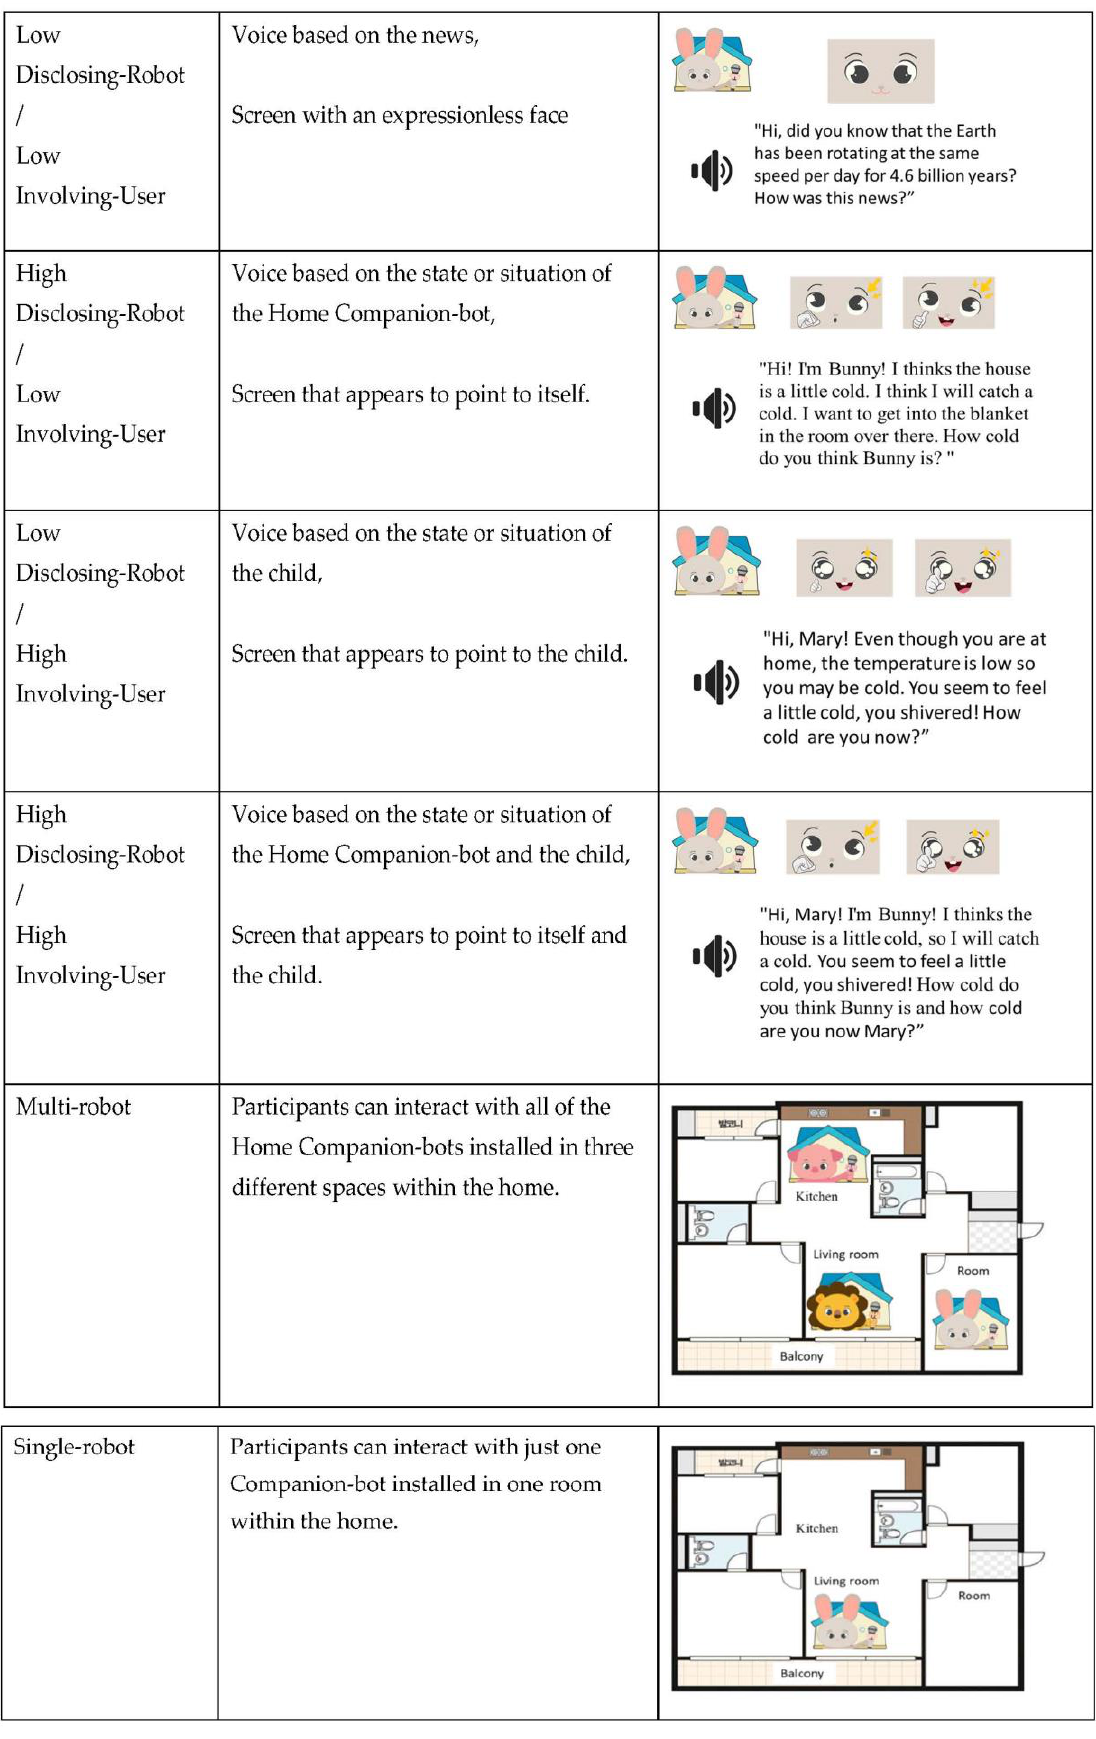
Figure 2. Manipulation of disclosing robot, involving user, and multi-robot conditions.